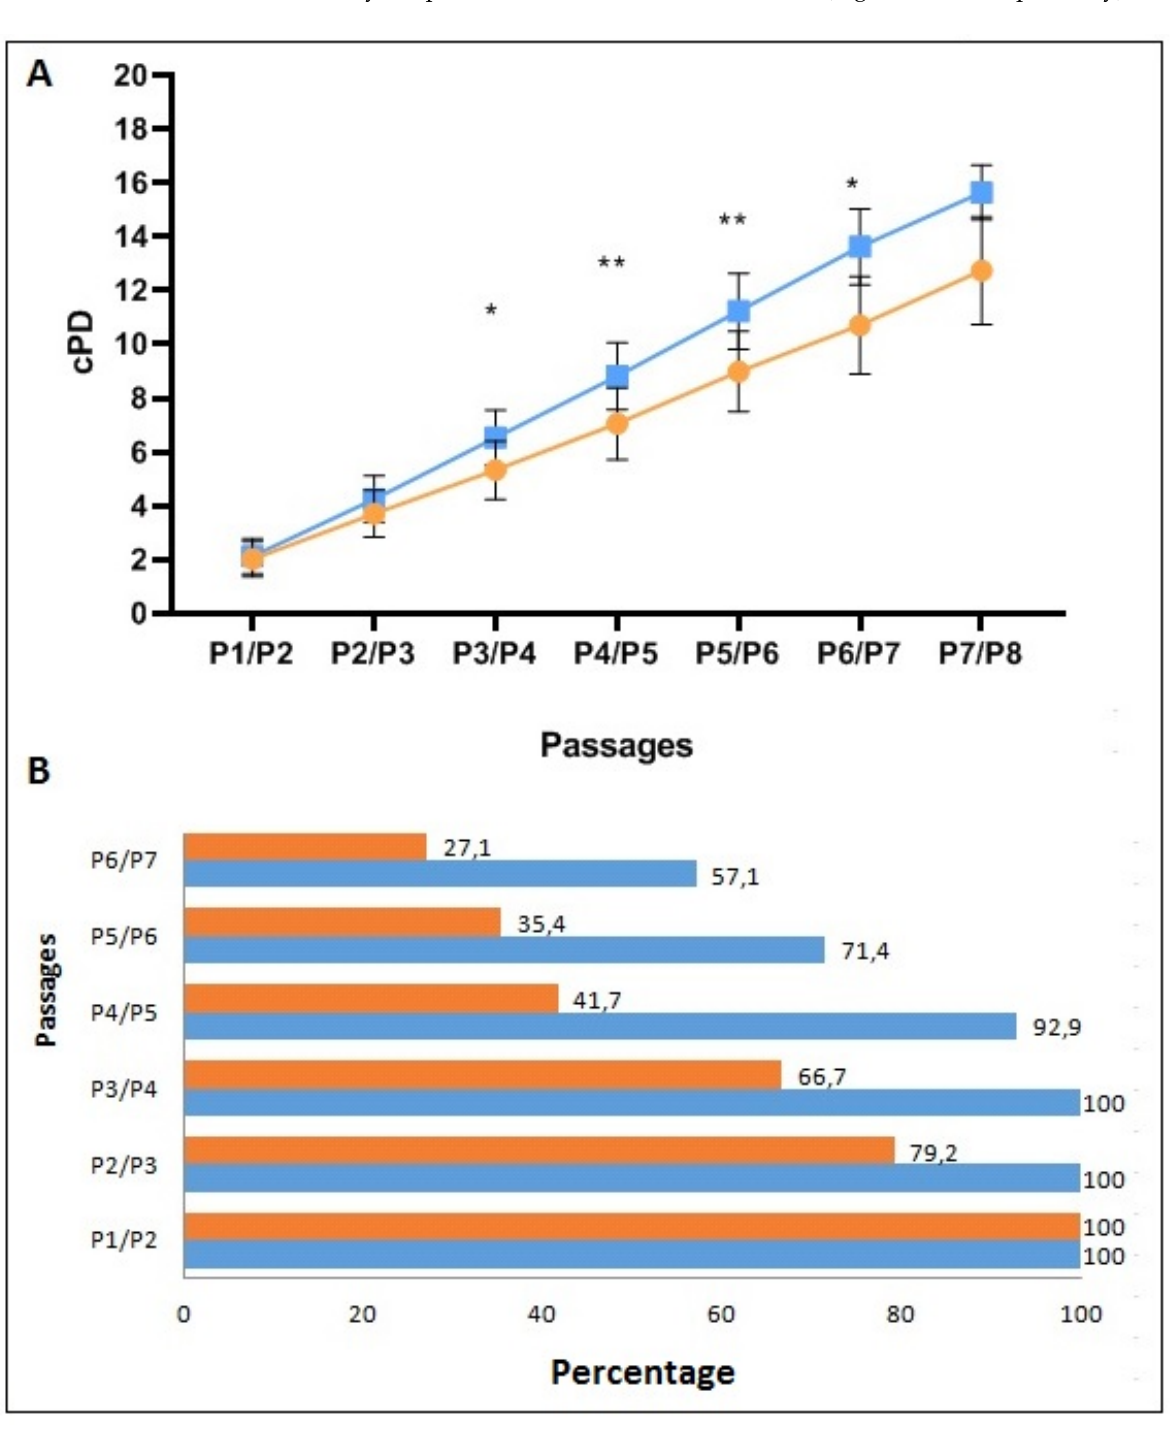
Figure 3. Proliferation capacity of AL- and HD-MSCs at different culture passages. ( A ) Results, expressed as cPD calculated from P1/P2 to P7/P8 in AL-MSCs (orange line) and in HD-MSCs (blue line), are shown as mean ± SD (* p ≤ 0.05; ** p ≤ 0.005). ( B ) The percentage of subjects at each culture passage is shown at the right end of the bars. AL-MSCs (orange bar), HD-MSCs (blue bar).